Question: What type of chart is this?
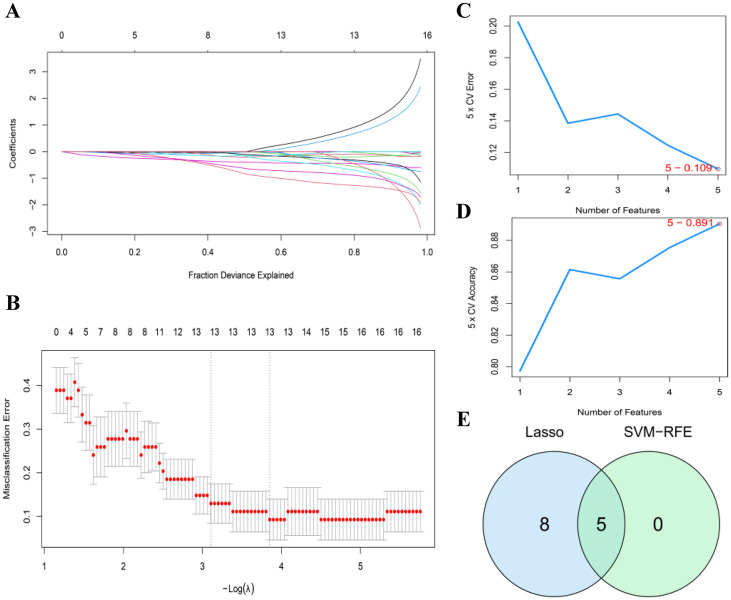
Answer: line